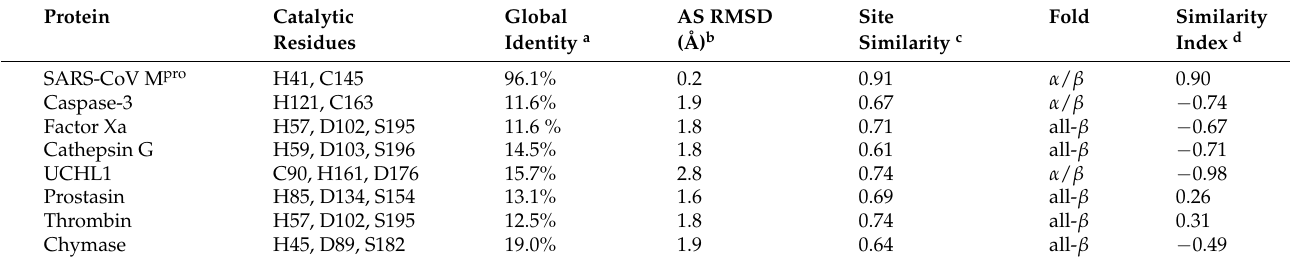
Table 2. Similarity of proteins and active